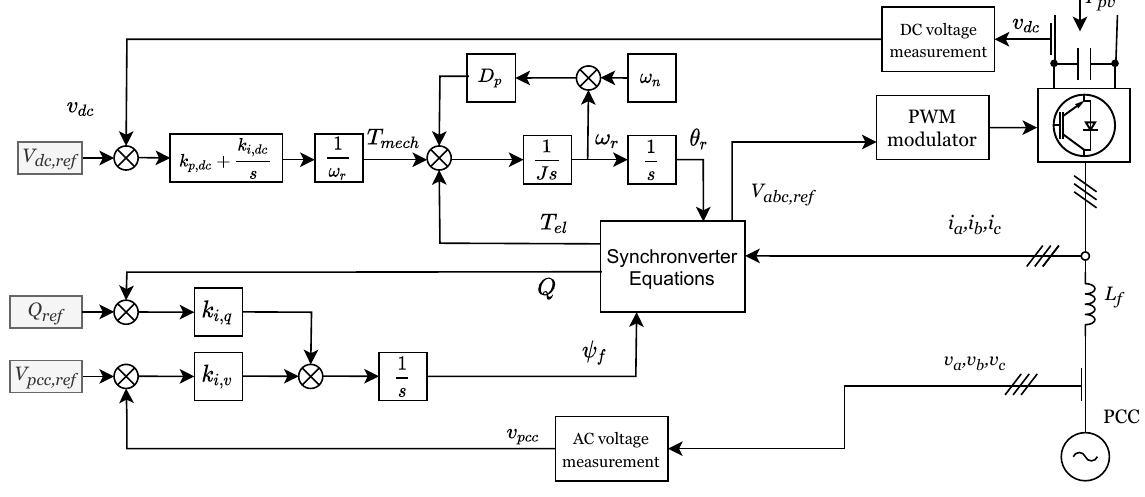
Figure 3. Synchronverter block